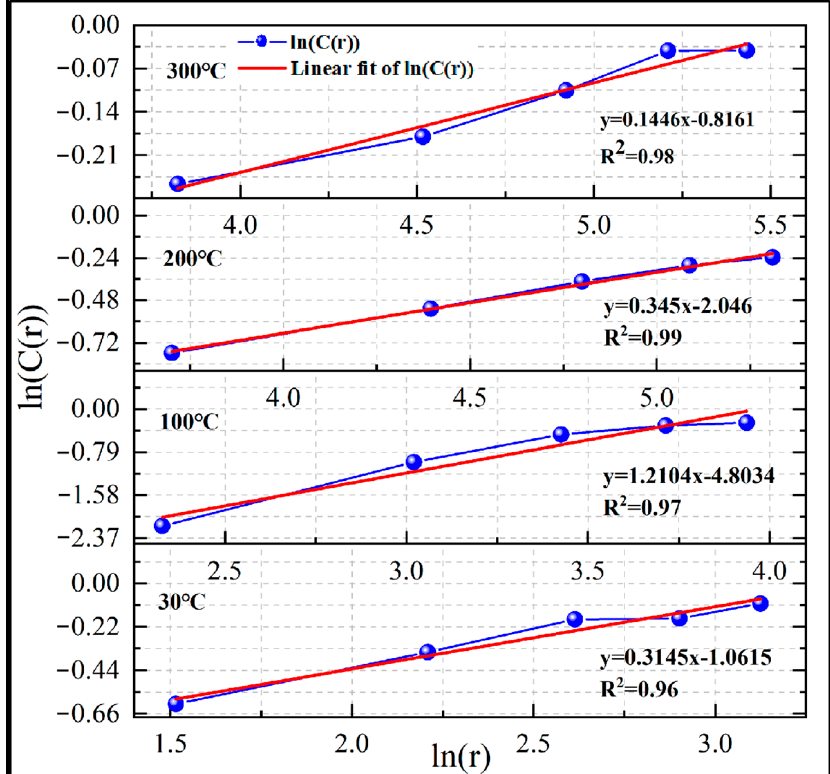
Figure 10. Fit curve plot of double logarithmic relationship at different temperatures.